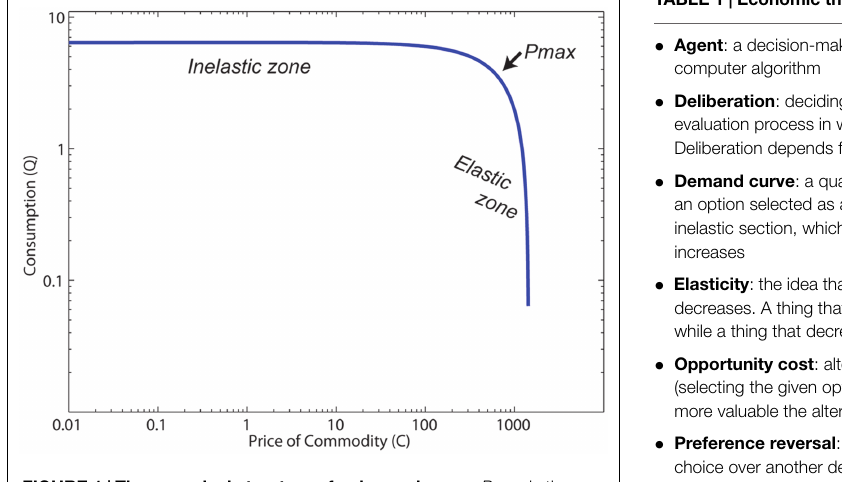
FIGURE 1 | The canonical structure of a demand curve . Pmax is the point at which elasticity E = (cid:0) 1, and the elasticity transitions from inelastic (| E | < 1) to elastic (| E | > 1).